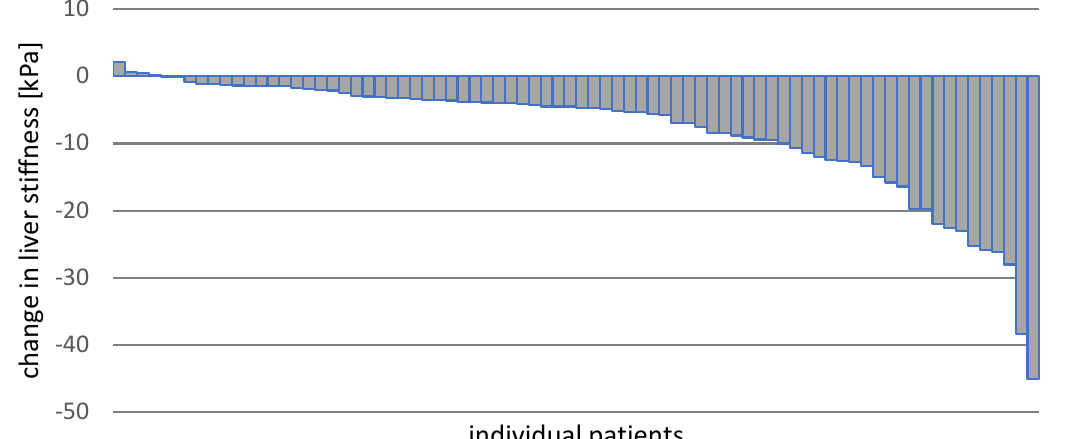
Figure 4. Changes in the liver stiffness between baseline and 5yFU in patients with available paired